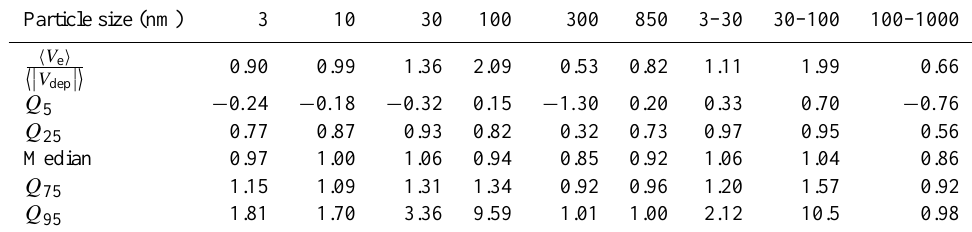
Table 1. Statistics of the ratio of the flux at the canopy top to deposition sink integrated over the canopy over a 10-day period in May 2013. (cid:12) (cid:12)(cid:11) (cid:10)(cid:12) The average statistics (cid:104) V e (cid:105) and were averaged over the simulation period first and then the ratio was found, whereas the percentile (cid:12) V dep statistics apply for the ratios V e (cid:12) obtained from model simulations for each 10min period. (cid:12) (cid:12) V dep (cid:12)